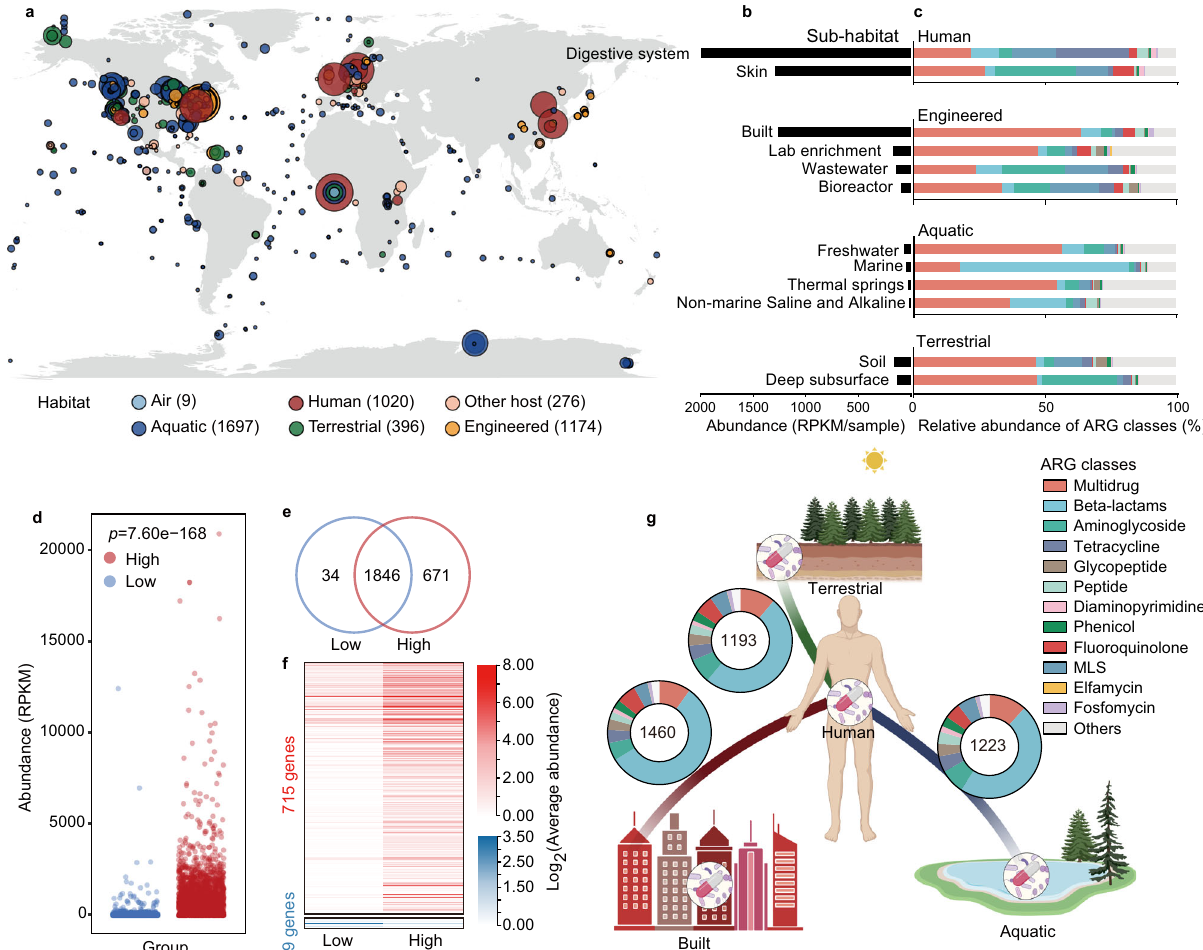
Fig. 1 Distribution patterns of antibiotic resistance genes (ARGs) globally. a Geographic distribution of samples with ARG abundance in various habitats. Each point indicates one sampling location, rounded to the nearest degree, with point size re fl ecting the number of samples, and point color indicating the habitat. Samples with the unclassi fi ed location was showed as longitude = 0 and latitude = 0. b Abundance of ARGs in each sub-habitat. Digestive system of human, mainly including the fecal samples, had the highest abundances of ARGs. c Composition of antibiotic resistome in each sub-habitat. Only sub- habitats containing at least 20 samples are shown. d High-intensity human activities signi fi cantly promoted the abundance of ARGs. Each dot represents one sample ( n = 1643 and 2309 samples for Low- and High-group, respectively). The p value represents the statistical signi fi cance (two-tailed Welch ’ s t - test). e Number of ARGs speci fi c or shared in the areas with low- or high-intensity human activities. There were 671 ARGs speci fi cally detected in high- intensity human activities environment. f The abundance of 715 and 29 ARGs signi fi cantly increased in high- and low-intensity human activities environment, respectively (adjust p < 0.05, two-tailed Welch ’ s t -test; Supplementary Data 3). g ARGs shared between the human-associated and three main habitats. Number in the circles represents the number of shared